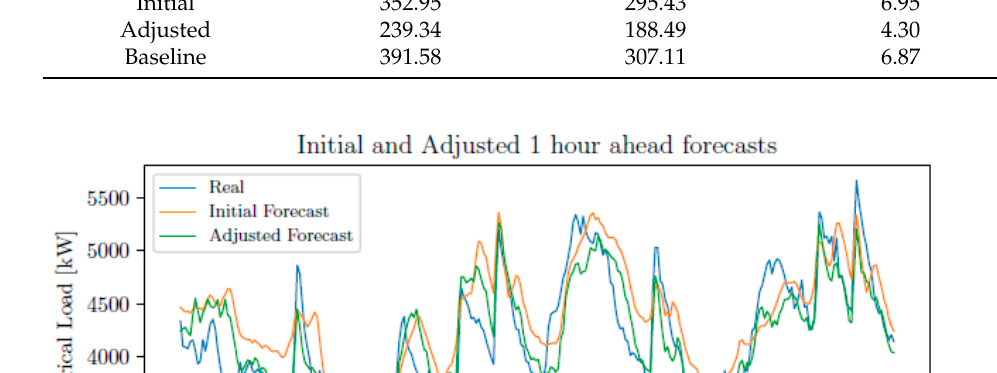
Table 12. Results of the 1-h-ahead forecasts.